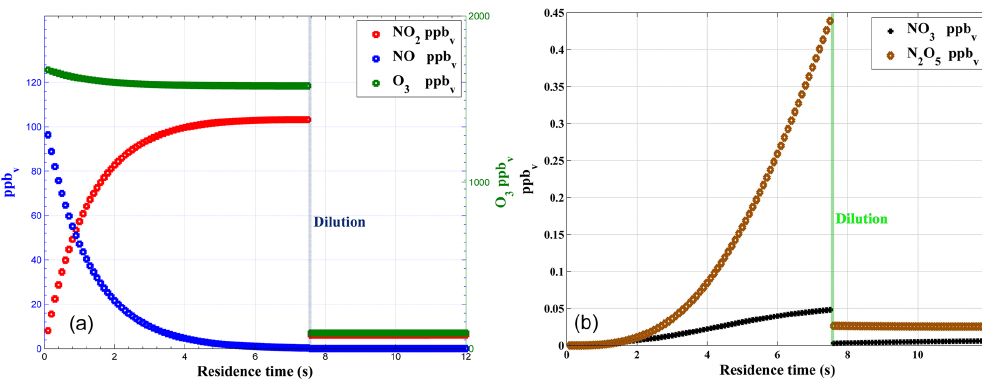
Figure 3. Box model simulation of gas phase titration of NO and O 3 (a) with loss of NO 2 due to the formation of NO 3 and N 2 O 5 (b) .